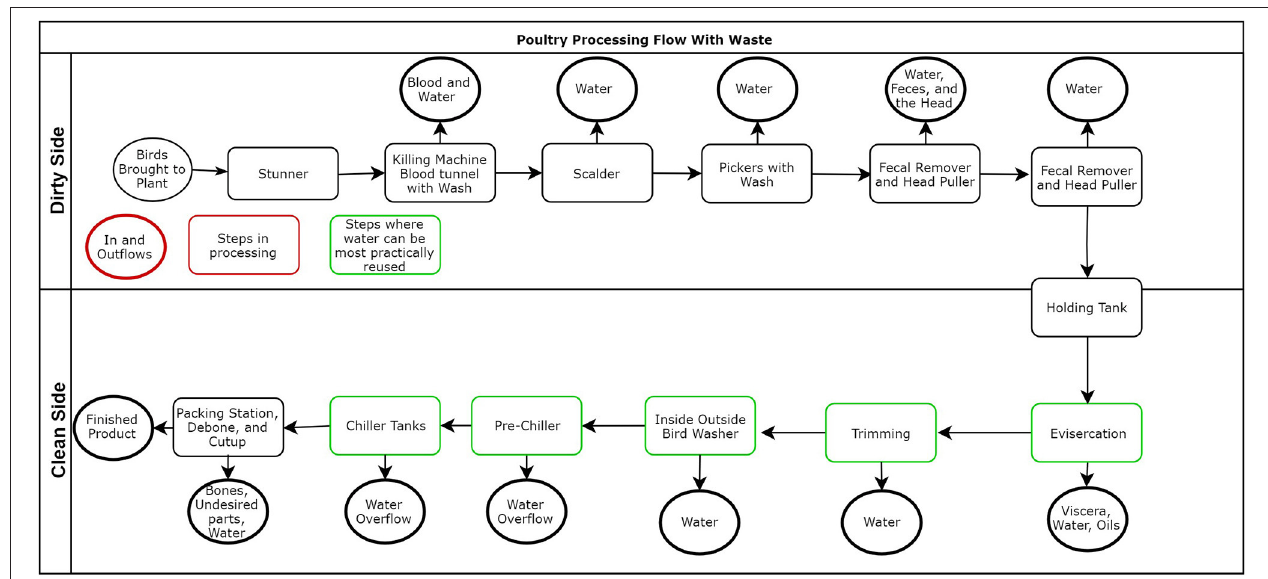
FIGURE 1 | Depicts the layout of a typical poultry slaughter and processing facility. The outflow from each area is also detailed. The figure demonstrates that at almost every step water is a component of the waste ( Keener et al., 2004; Avula et al., 2009). Steps in green highlight regions where physical and chemical treatment may be most practical for water reuse (Avula et al.,